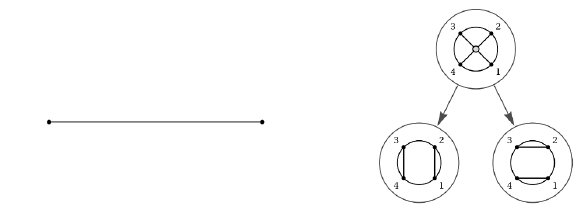
Figure 4 . The orthogonal momentum amplituhedron O 2 and its boundary